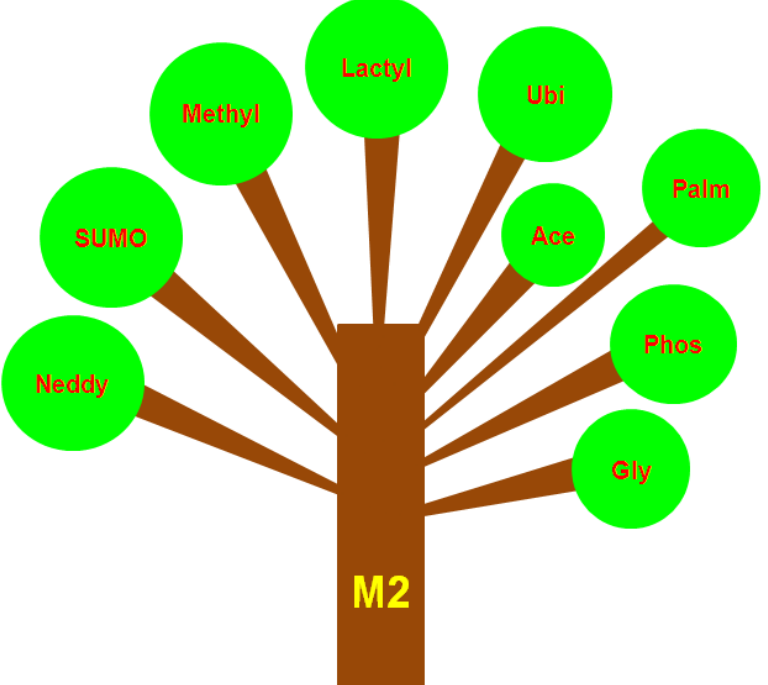
Figure 1. PTMs occurring in M2 macrophages can be likened to the different branches of a thick tree. These branches endow the tree with nutrition and energy from the environment that are necessary for its growth. Analogous to branches of the tree, PTMsare also important for M2 macrophages during their service in the tumor microenvironment, which endows functional diversity and plasticity for M2 macrophages. In these schematic graphics, the trunk-labeled M2 actually stands for M2 macrophages and the different branches represent the different PTMs, including neddylation (neddylation), SUMO (SUMOylation), methyl (methylation), lactyl (lactylation), Ubi (ubiquitylation), Ace (acetylation), Palm (palmitoylation), Phos (phosphorylation), and Gly (glycosylation).